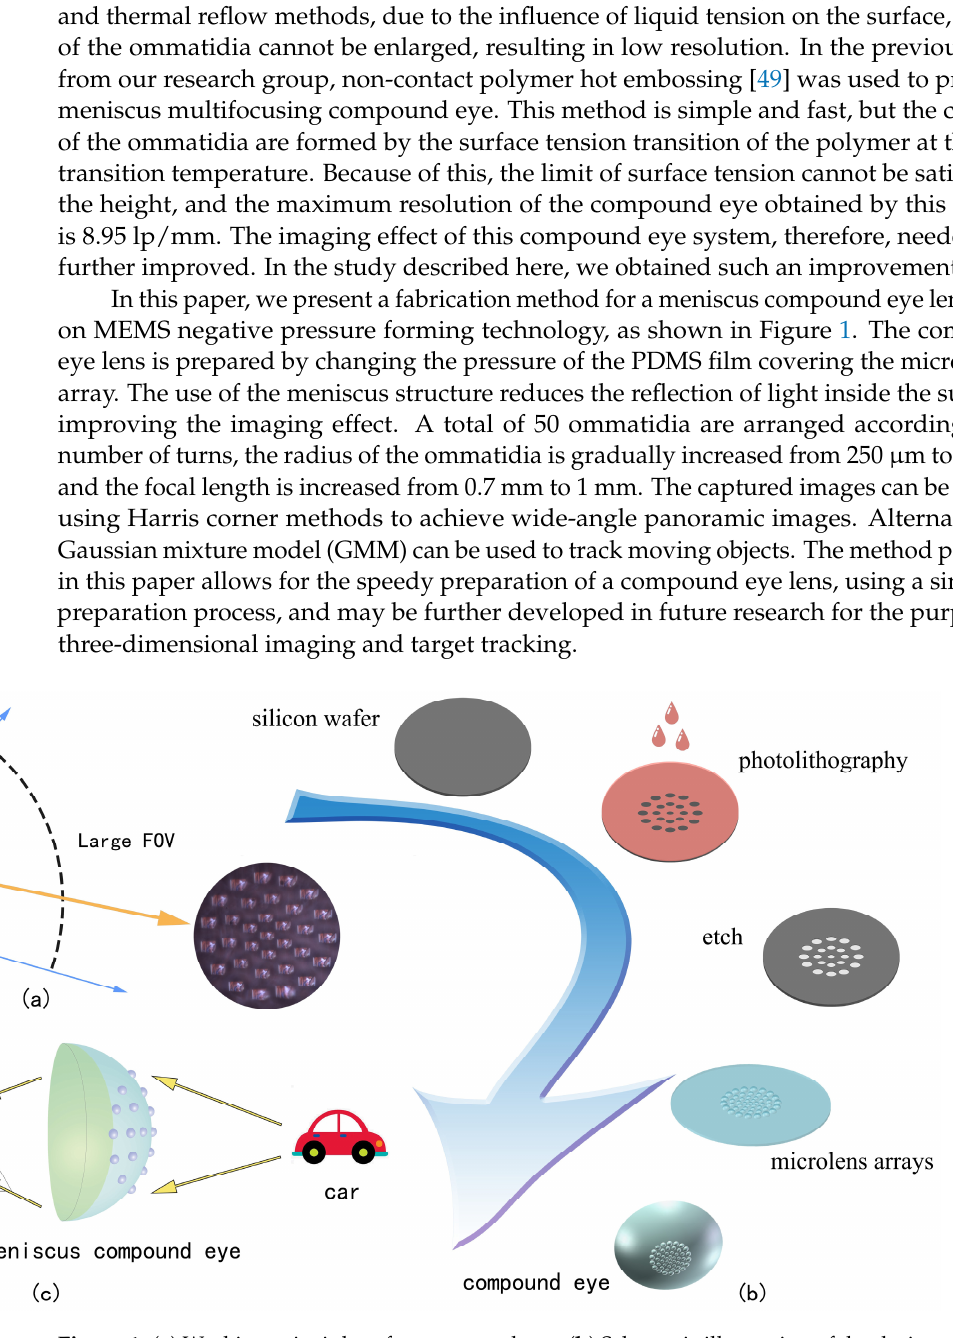
Figure 1. ( a ) Working principles of a compound eye. ( b ) Schematic illustration of the design principles of the meniscus compound eye. ( c ) The regulation principle of the meniscus compound eye.